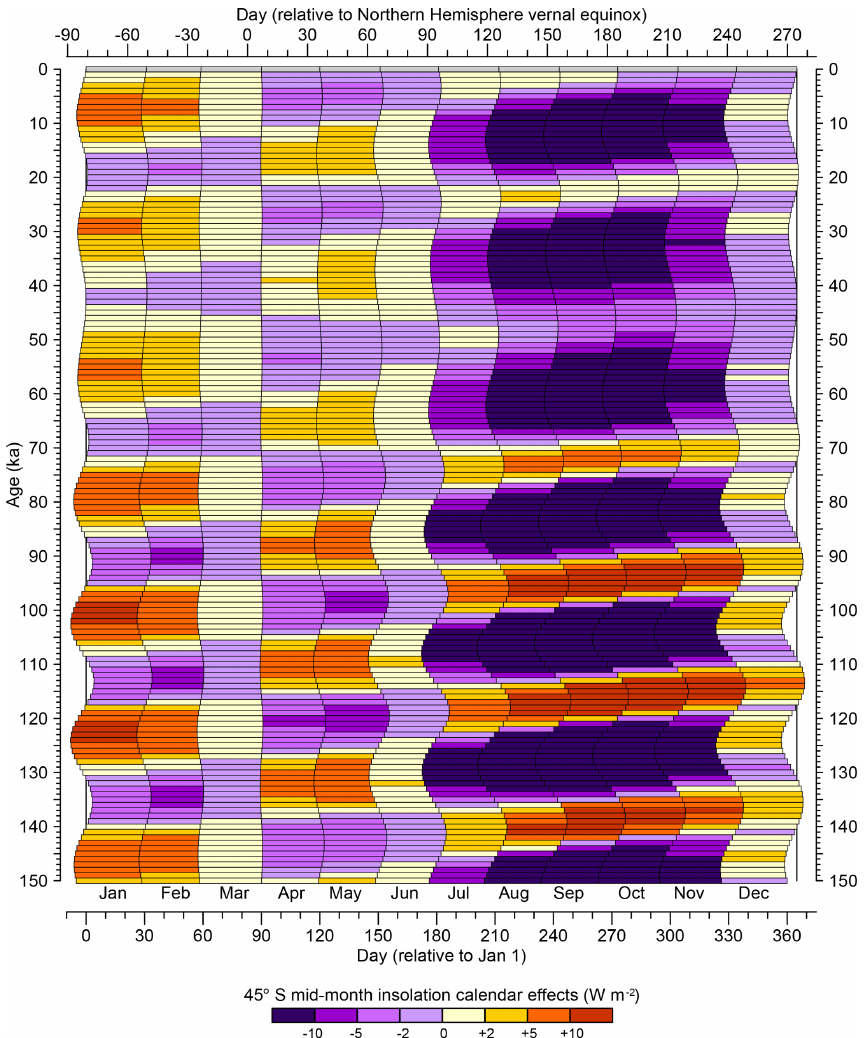
Figure 5. Calendar effects on insolation at 45 ◦ S. The differences plotted show the values of average daily insolation at mid-month days identified using the appropriate fixed-angular paleo calendar minus those using the fixed-length definition of present-day months, with orange hues showing positive differences and purple hues negative differences. As in Fig. 1, variations over the past 150kyr in the beginning and ending days of fixed-angular months for a 365d noleap calendar are shown for 1kyr intervals beginning at 0ka (1950 CE). The left side of each horizontal bar shows the beginning day, while the right side shows the ending day of a particular month for each 1kyr